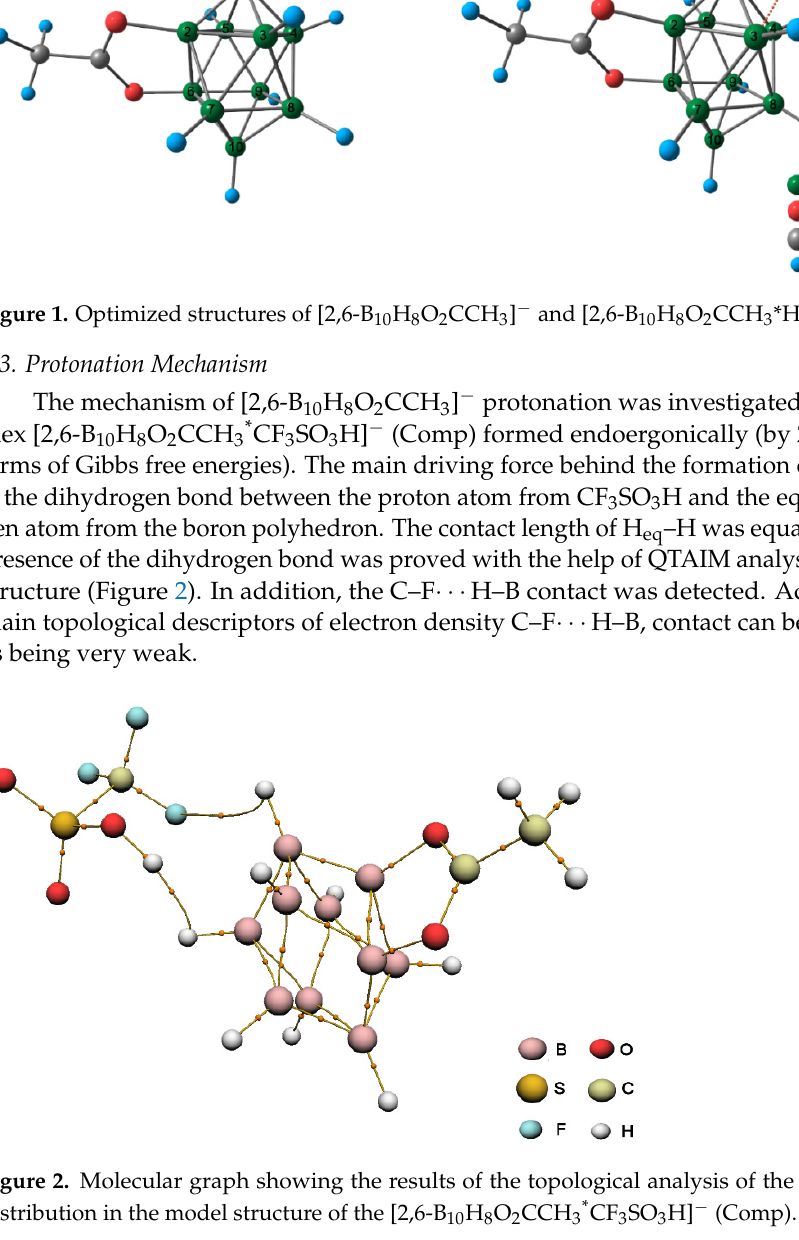
Figure 1. Optimized structures of [2,6-B 10 H 8 O 2 CCH 3 ] – and [2,6-B 10 H 8 O 2 CCH 3 *H fac ] 0 .